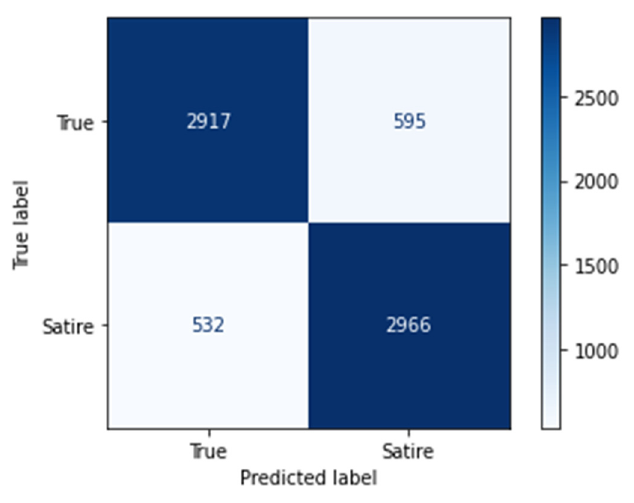
Figure 10. Confusion matrix for SARC dataset.